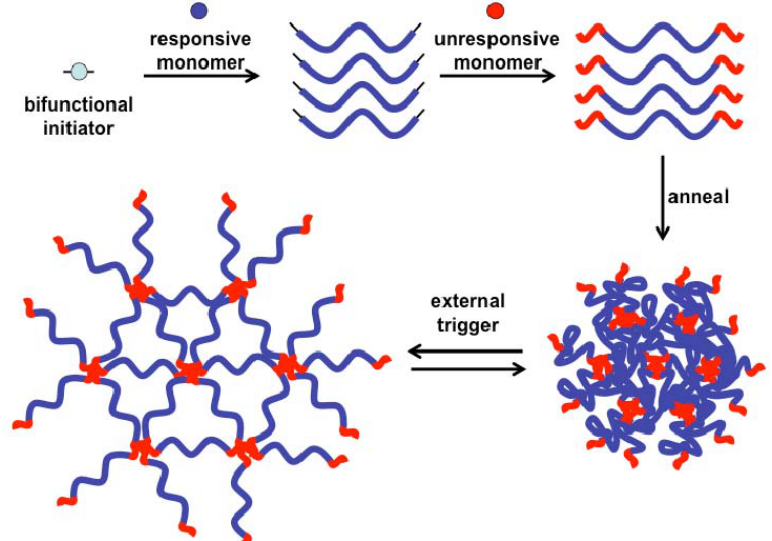
Figure 4. Schematic representation of the synthetic procedure and post-synthesis processing employed for the general preparation of a symmetrical triblock copolymer network using a bifunctional